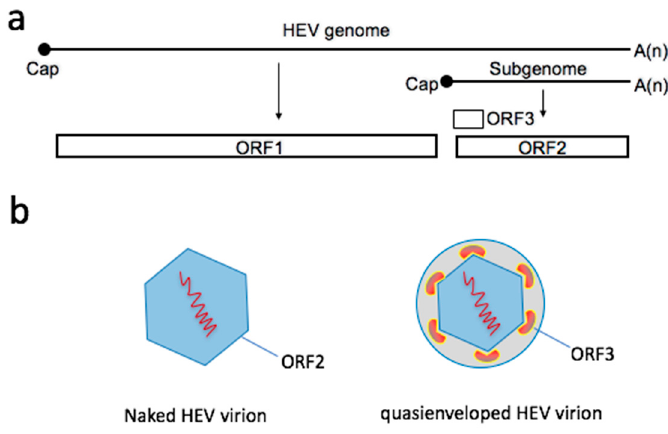
Figure 1. The hepatitis E virus (HEV) genome, its encoded proteins ( a ), and two types of virions ( b